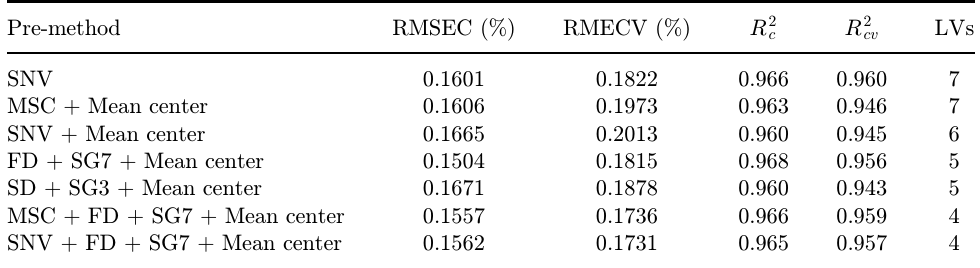
Table 1. Results of di®erent spectral pretreatment methods for in-line NIR quantitative model. Pre-method